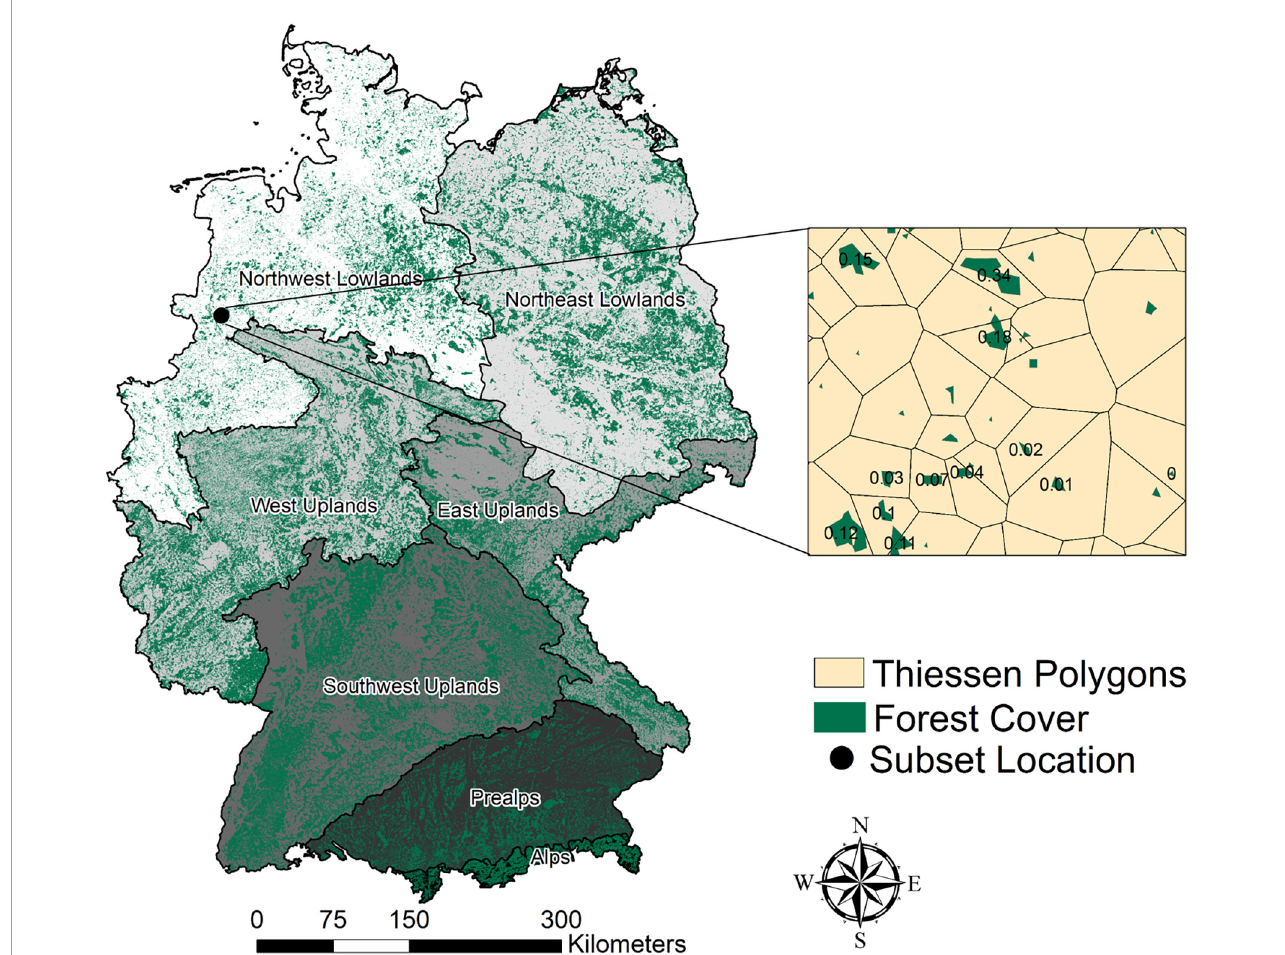
FIGURE1 Map of Germany categorized by seven ecoregions (left, Bundesamt für Naturschutz [BfN], 2017). The Baltic Sea and North Sea with low forest cover shares are excluded from the original dataset. Forest cover (green) is based on the Global Forest Change dataset (Hansen et al., 2013) with forest areas of 2021 (defined per pixel as more than 50% forest coverage based on Hansen et al., 2013). An example region of a forest-covered area with corresponding Thiessen polygons and corresponding connectivity values in the range of 0–1 is shown on the